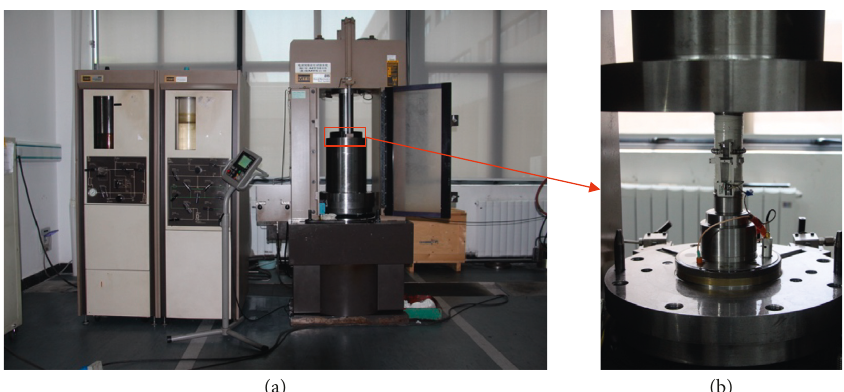
Figure 2: Photos of the (a) whole MTS815 rock mechanics test system and (b) sample under loading.